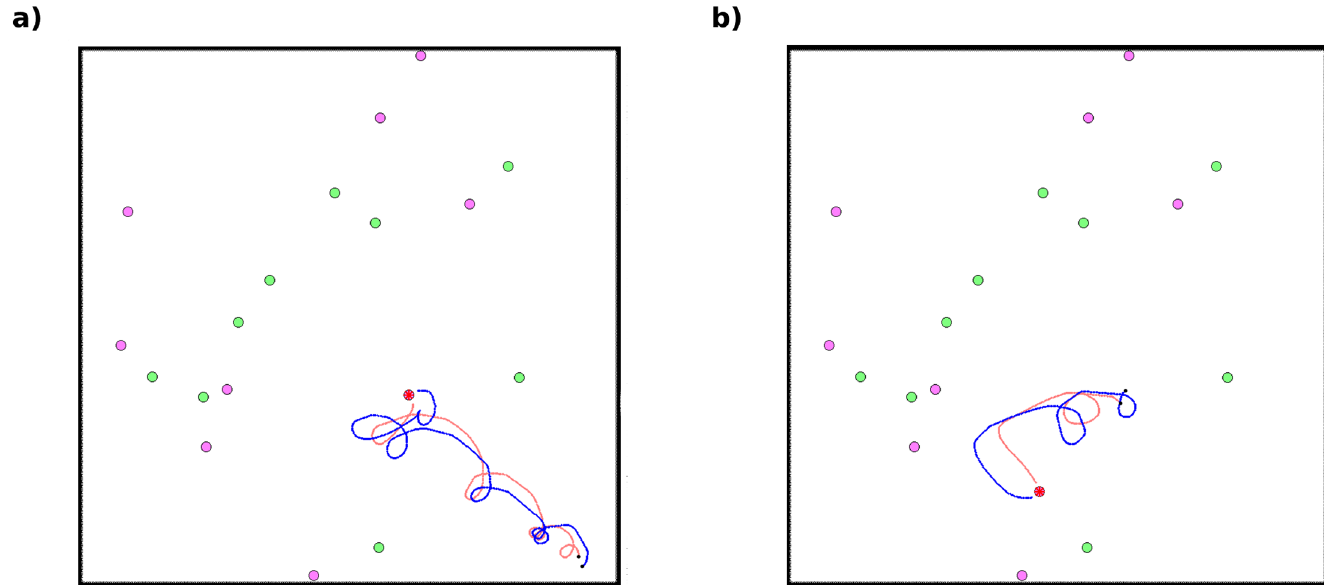
Fig 8. Snapshots of a simulation after two hunts. In each of these snapshots, we show the path travelled by each hunter (in different colours) since their last prey was hunted. The black dots represent the positions of the hunters at their last